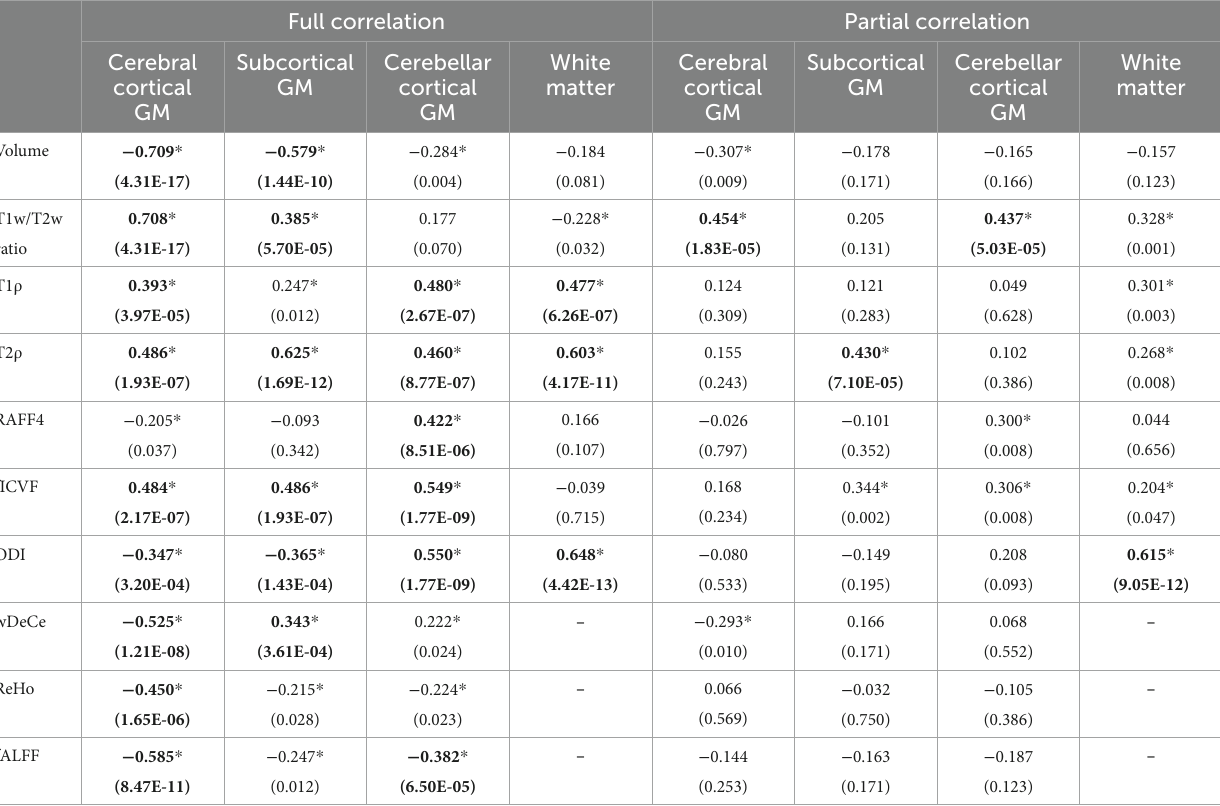
TABLE 1 Full and partial rank correlations between the age and individual MRI metrics in the four predetermined regions of interest [cerebral cortical grey matter (GM), subcortical GM, cerebellar cortical GM and white matter (not provided for resting-state fMRI metrics)]. Full